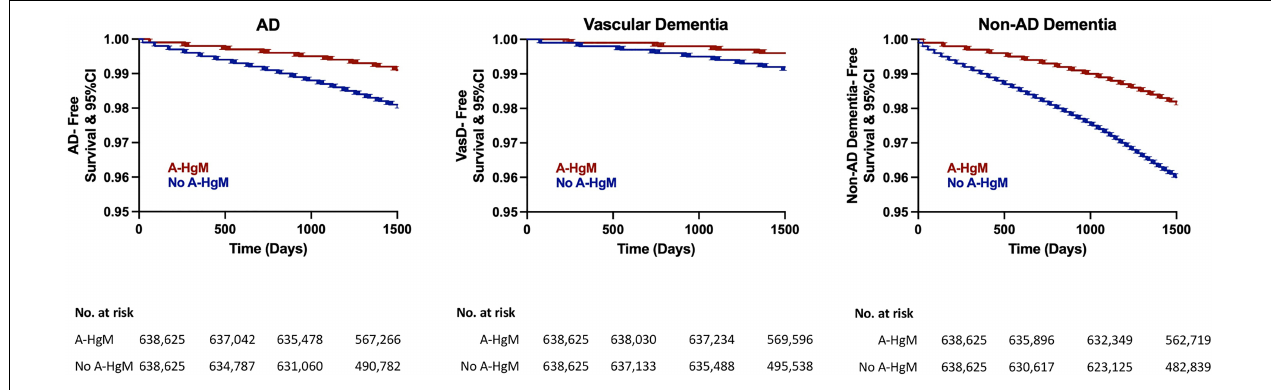
FIGURE 5 | Kaplan–Meier survival curves for disease-free survival for AD and ADRD subtype (vascular dementia and non-AD dementia). AD, Alzheimer’s disease; A-HgM, anti-hyperglycemic medication; CI, confidence